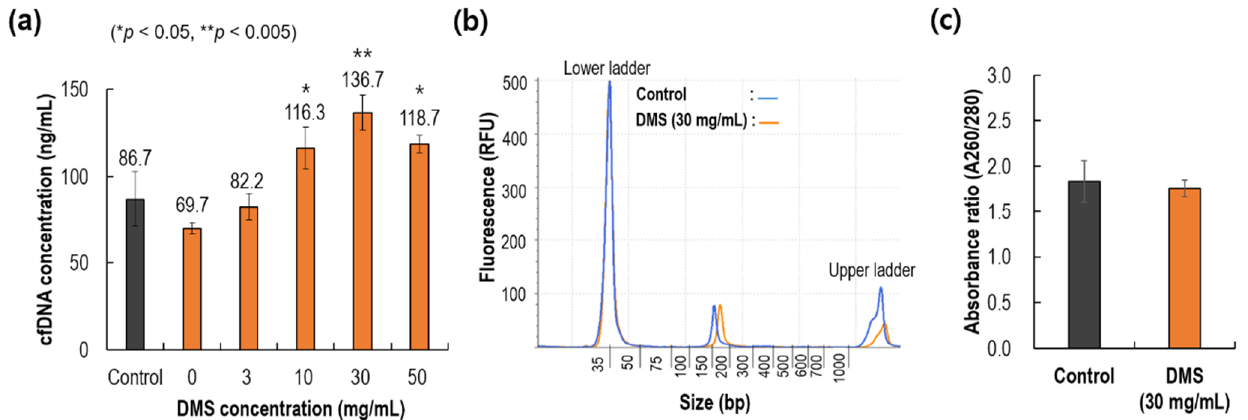
Figure 3. Comparison of cfDNA extraction performance with varying DMS concentrations. ( a ) Effect of DMS concentration (0, 3, 10, 30, and 50 mg/mL) on cfDNA extraction yields compared to that of control (QIAamp). ( b ) Size analysis of cfDNA extracted from control and present sample (30 mg/mL). ( c ) Absorbance ratios for control and present sample (30 mg/mL).